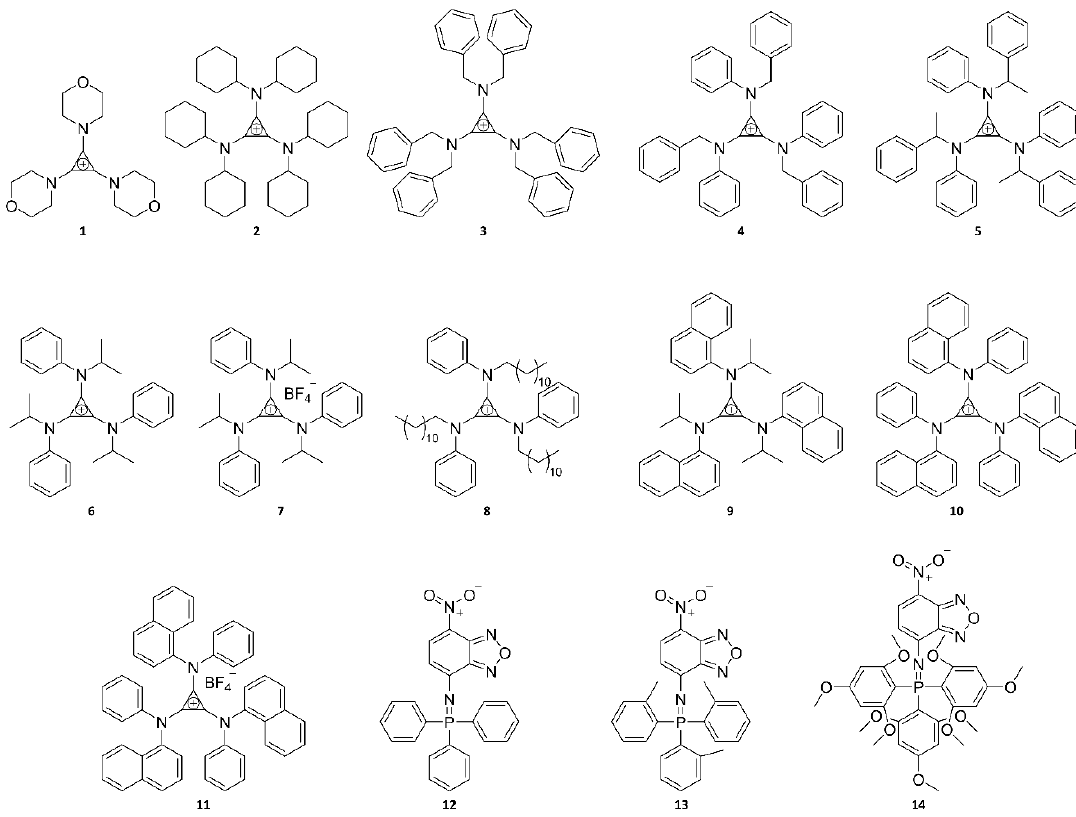
Figure 5. Chemical structure of organic probes (probes 1 to 14 ) for bioimaging in the ultraviolet range.